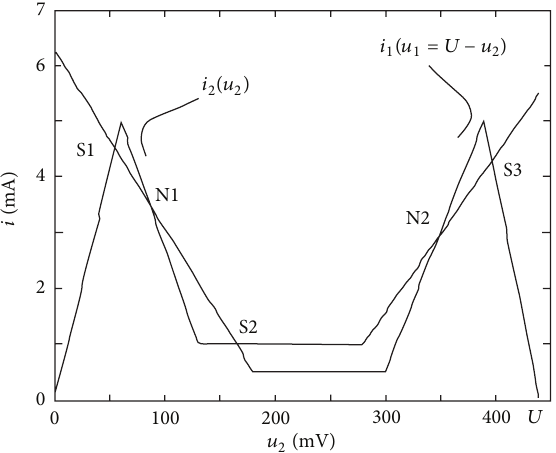
Figure 2: I-V characteristics of RTDs and singular points projected into the plane 𝑖 , 𝑢 2